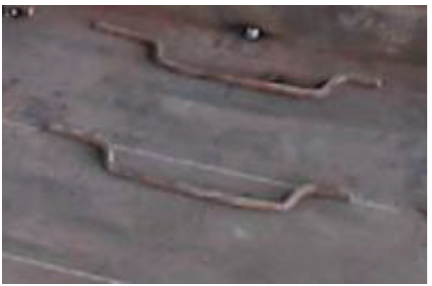
Figure 5: Bent bars.